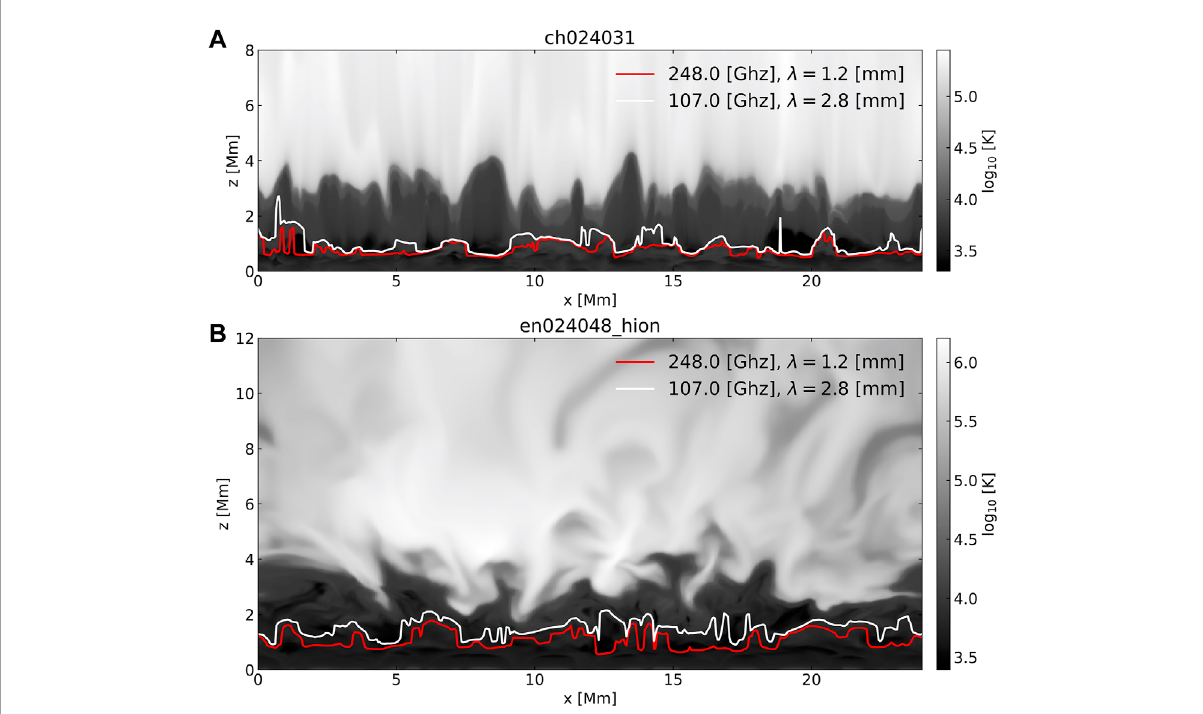
FIGURE 2 Simulated logarithmic gas temperature (gray-scale) in vertical slices of two 3D rMHD Bifrost simulations: (A) coronal hole and (B) enhanced network region. The solid lines represent the heights at which the optical depth is in unity at a wavelength of 1.2 mm (red) and 2.8 mm (white), which correspond to ALMA bands 6 and 3, respectively (see also Figure 3 ). It is to be noted that these heights are only rough proxies of typical formation heights, whereas the contribution functions can have multiple peaks along the line-of-sight as a result of the complicated thermal structure as can also be seen from the temperature response functions in Figure 4 .